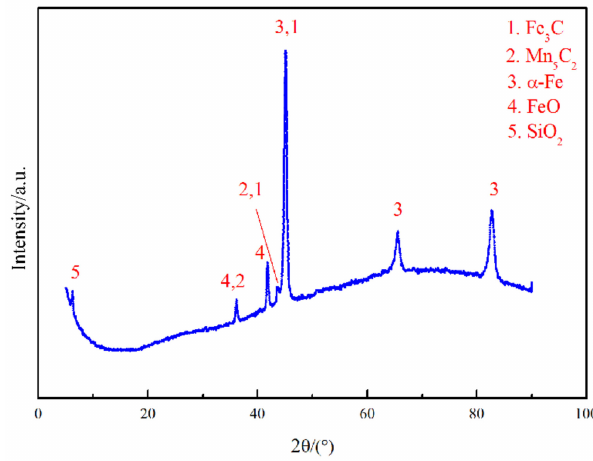
Figure 4. XRD pattern of the cladding layer of specimen